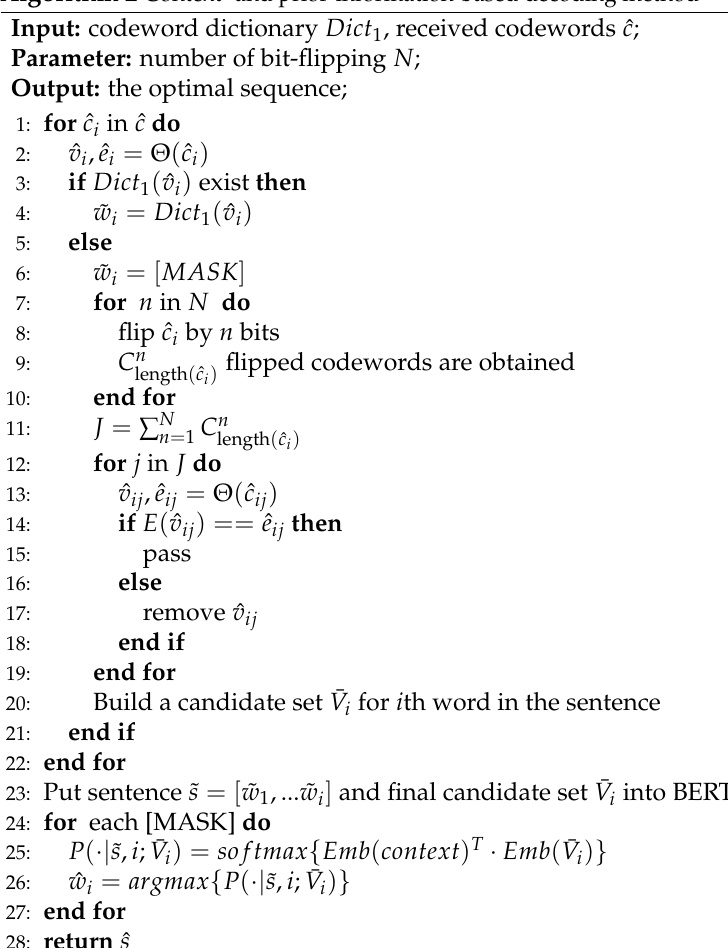
Algorithm 2 Context- and prior-information-based decoding